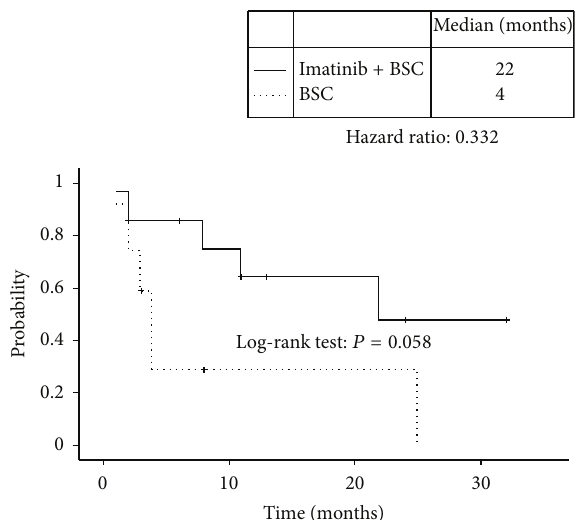
Figure 3: Overall survival curves in the imatinib plus BSC group (solid line) and the BSC alone group (dotted line). Median overall survival times were 22 months and 4 months, respectively. The hazard ratio for imatinib plus BSC was 0.332 ( 𝑃 = 0.058 , log-rank test). BSC, best supportive